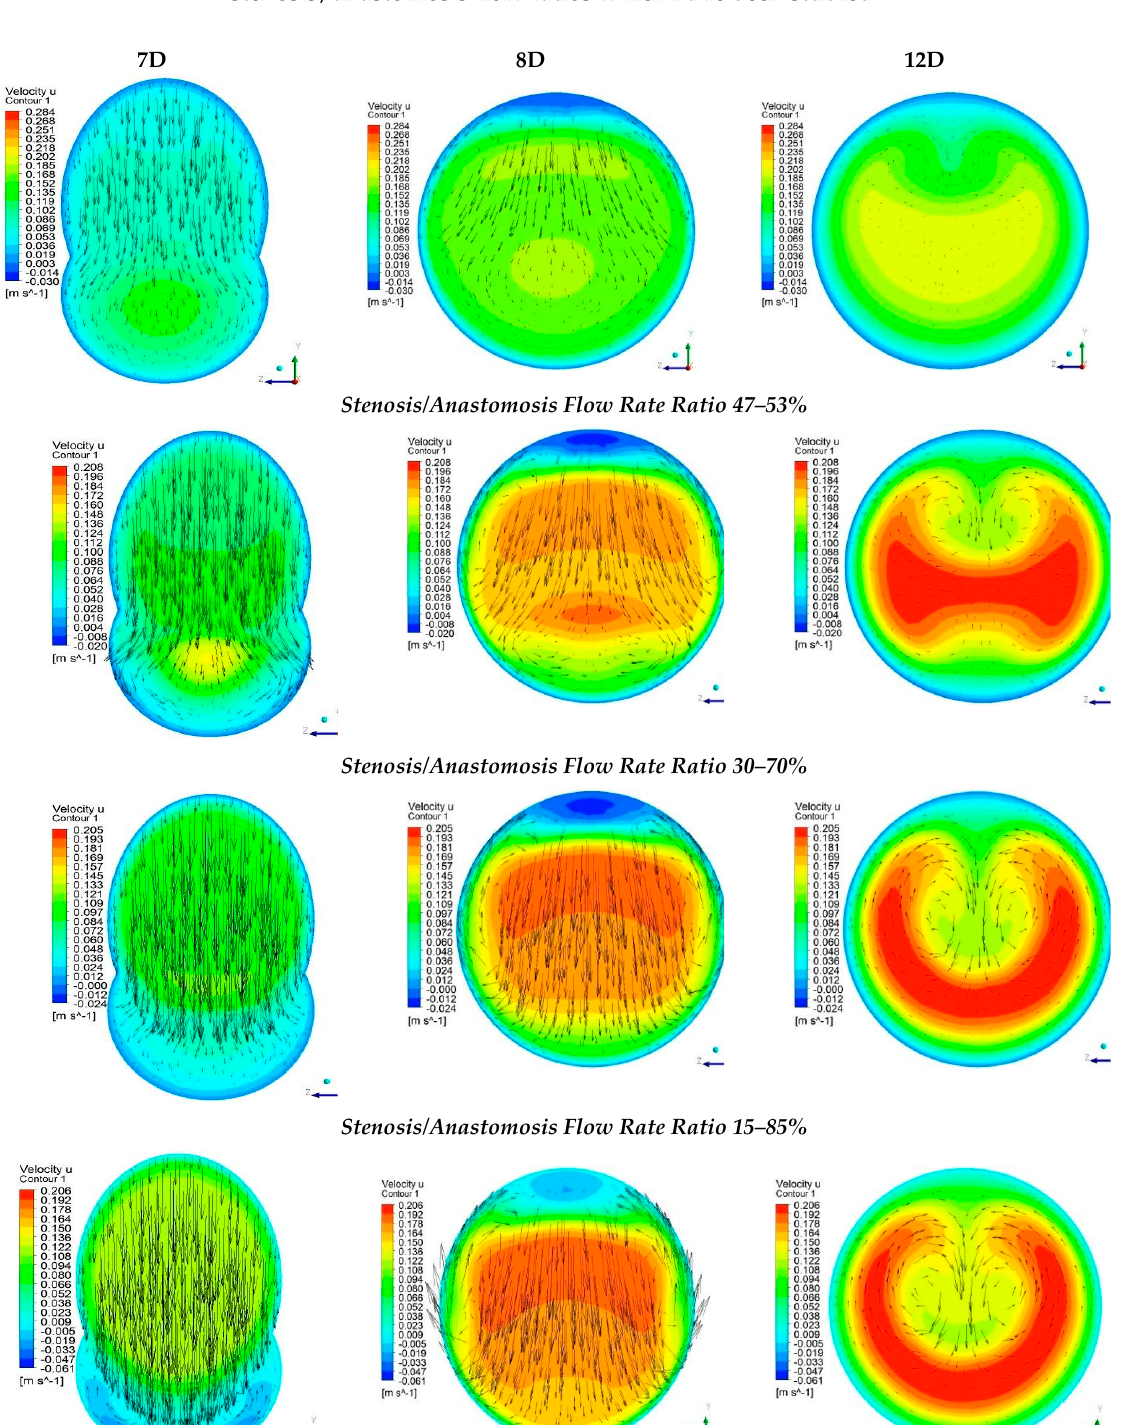
Figure 11. Identification of the cross sections for computational result presentation along with the artery model.